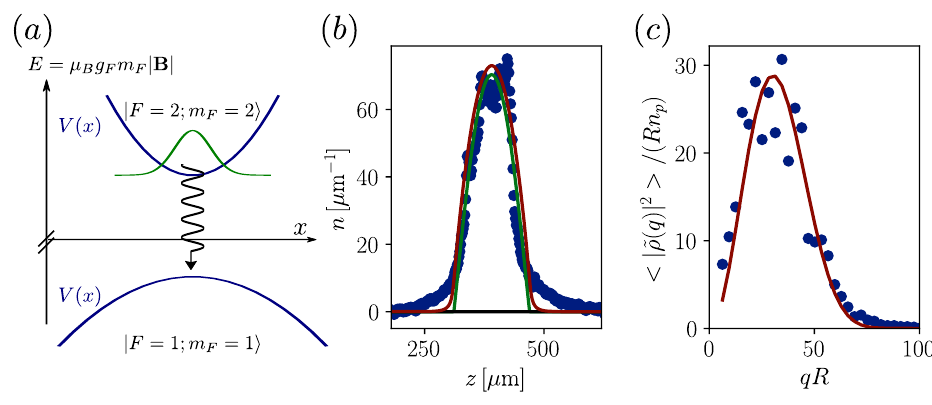
Figure 1: Implementation of one-body losses in our magnetically-confined gas and data analysis. (a) sketch of the MW coupling between the trapped and untrapped ( z ) , obtained averaging over about 20 images. state. (b) A typical density profile n 0 The data to which it corresponds (5 th data point of data set 6) is the encircled data point in Fig.(a). The shape expected for a quasicondensate is shown in green, with the peak density n as single fitting parameter. (c) Density ripples power spectrum p for the same data as (b), together with the theoretical fit yielding the temperature T . The red solid line in (b) is the density profile expected for a cloud at a temperature T using the Yang-Yang equation of state and the local density